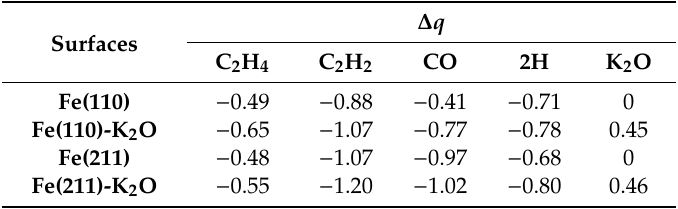
Table 2. The total Bader charge di ff erences ( ∆ q) of Fe atoms on the four surface models covered with and without surface species (C 2 H 4 , C 2 H 2 , CO, H 2 and K 2